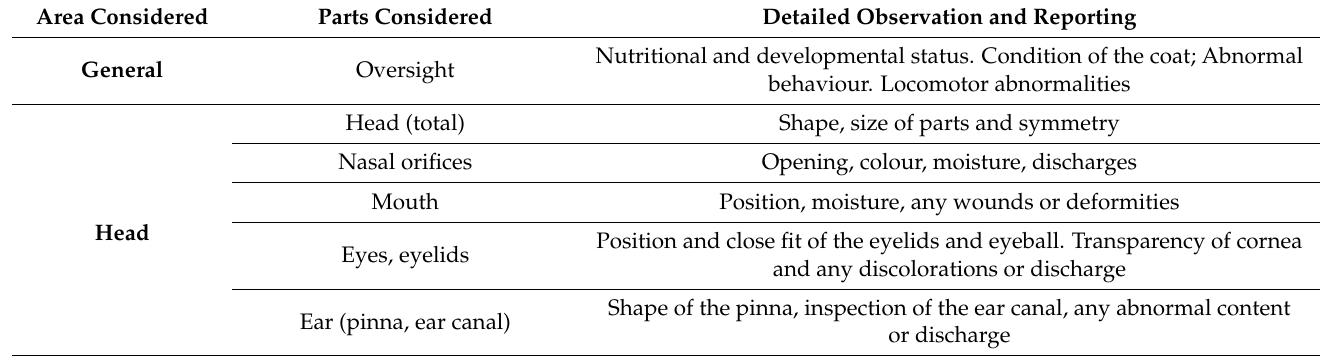
Table 2. Weekly Checklist inspection of animals (Adapted from Reporting clinical signs in laboratory animals from the FELASA Working Group Report,